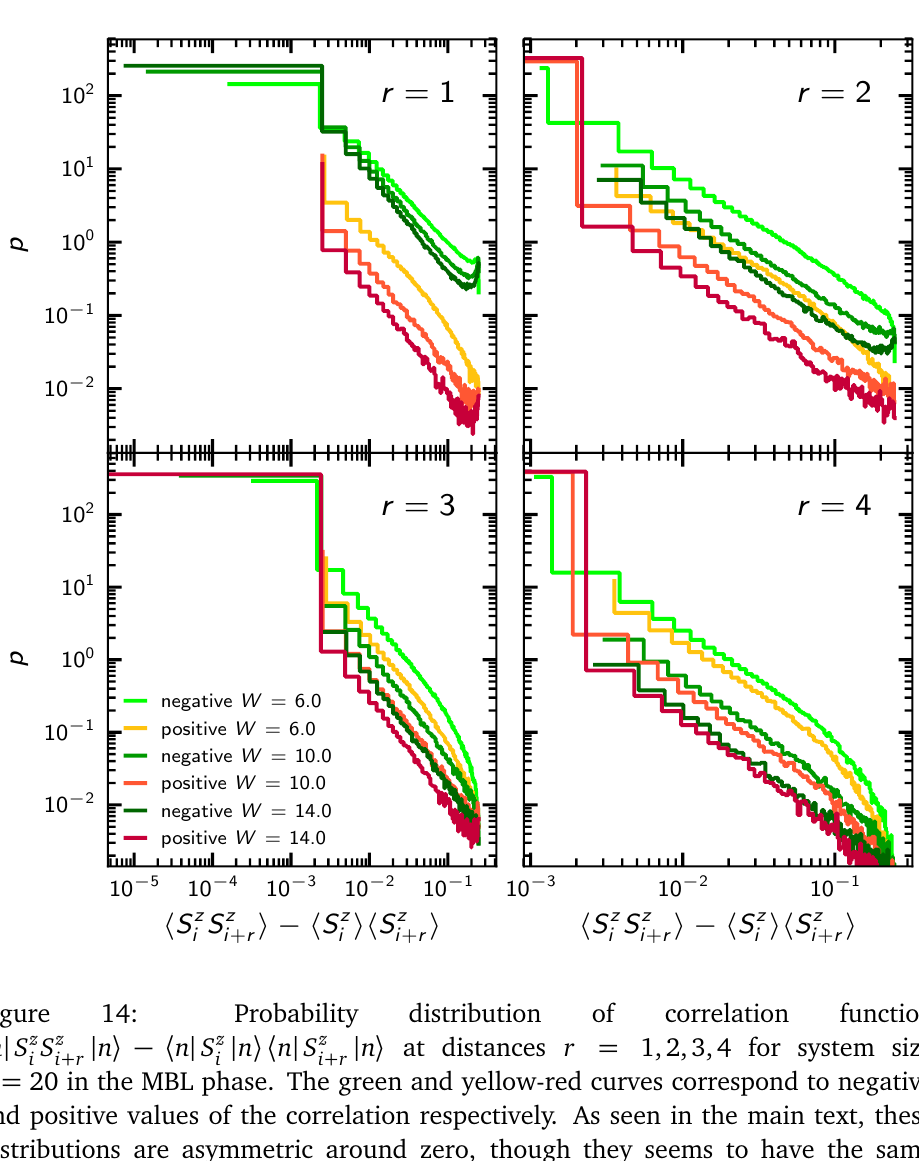
Figure 14: Probability distribution of correlation function 〈 n | S z | n 〉 − 〈 n | S z | n 〉〈 n | S z | n 〉 at distances r = 1,2,3,4 for system size S z i i + r i i + r L = 20 in the MBL phase. The green and yellow-red curves correspond to negative and positive values of the correlation respectively. As seen in the main text, these distributions are asymmetric around zero, though they seems to have the same power law behavior on both